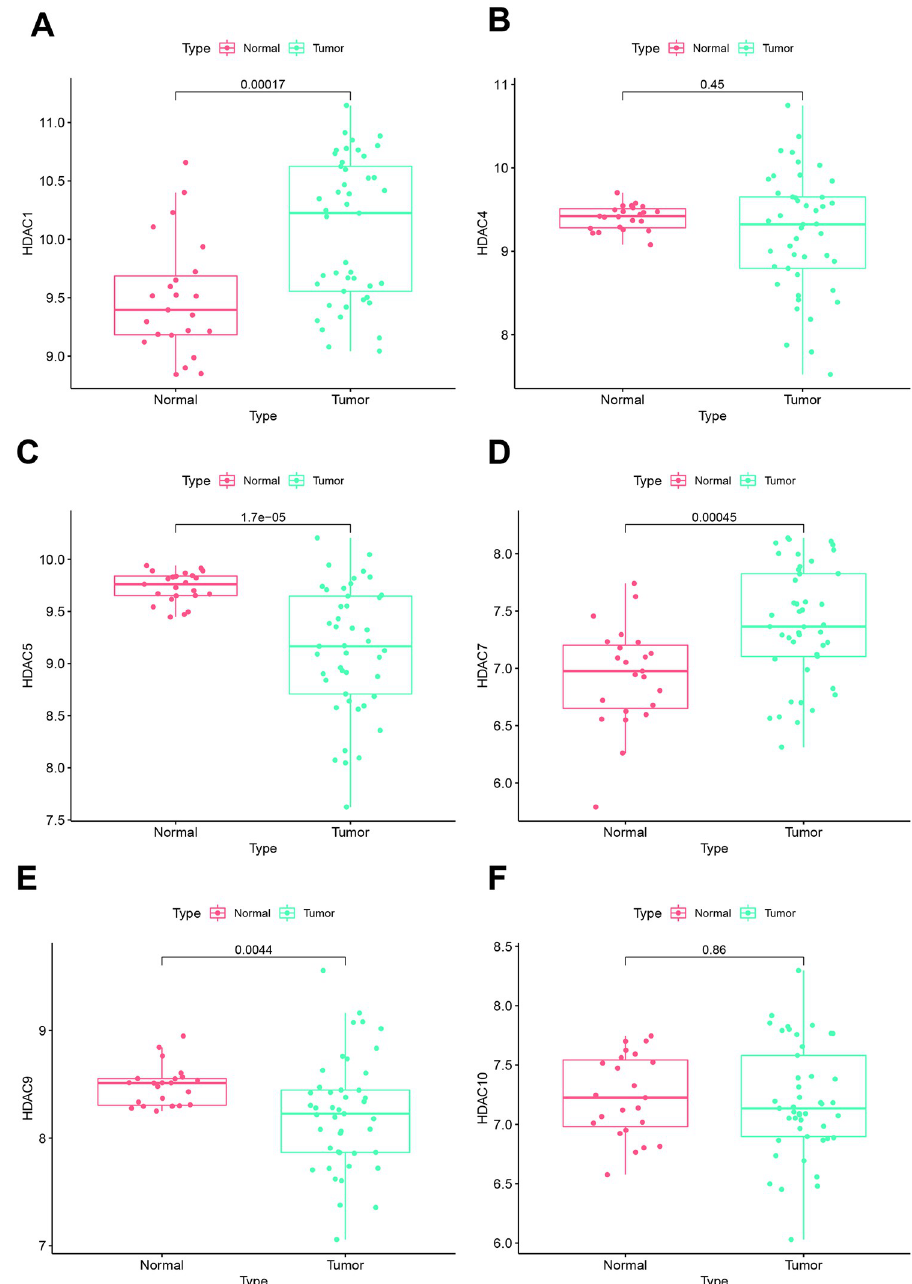
Fig 10. Expression levels of signature genes between tumor and normal tissue. A: HDAC1. B: HDAC4. C: HDAC5. D: HDAC7. E: HDAC9. F: HDAC10. of acetylation of regional core histones [20]. The degree of acetylation of histones is closely related to transcriptional activity: the acetylation density of core histones in transcriptionally active regions is high, while the acetylation density of inactive regions is low [21]. HAT pro- motes the depolymerization of chromosomes and activates transcription; while HDACs block DNA, thereby inhibiting the transcription process. Under normal physiological conditions,